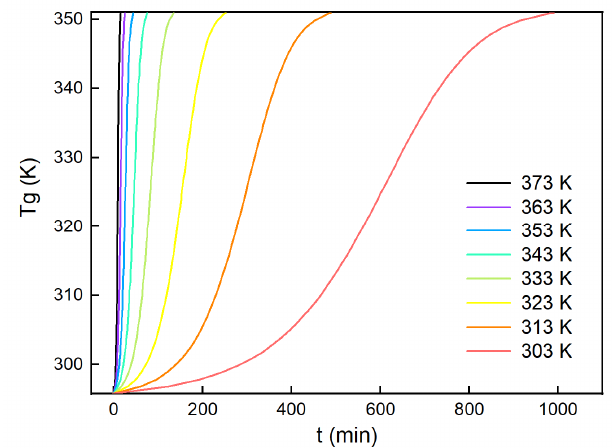
Figure 9. Relationship between glass transition temperature and time at constant temperatures. If T (cid:2917) was replaced by T, Equation (16) reflected the relationship between T and t. A plot based on this gave the glass transition curve, as shown in Figure 10. It is clear that the Tg of the H 6 XDI/BES system approached Tg (cid:2868) with the increase in cure time and curing temperature. After the glass transition occurred, the curing reaction rate decreased signif- icantly, because the motion of molecules was subjected to much greater hindrance.